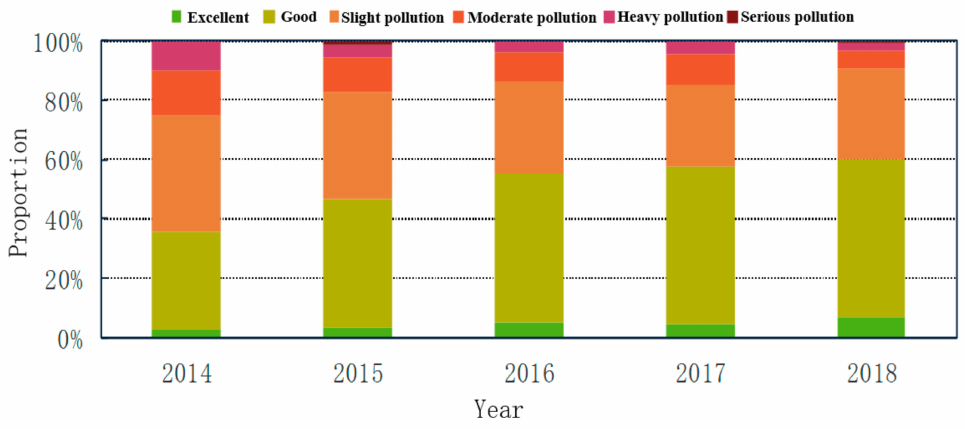
Figure 3. Statistical analysis of the di ff erent AQI categories from 2014–2018 in Weifang.